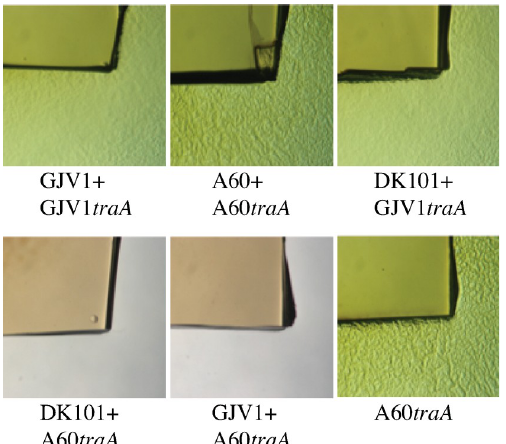
Fig 5. Inhibition of A60 traA swarming by DK101 and GJV1 is caused by TraA-independent killing. Mixes of kanamycin-resistant traA mutants with kanamycin-sensitive non-mutants were incubated on CTT agar without kanamycin and subsequently transferred on onto CTT agar with kanamycin. Lack of swarming out-growth on the kanamycin plates indicates killing of the focal traA mutant by the focal non-mutant prior to exposure to kanamycin. None of the traA mutants are killed by its parental strain and GJV1 traA is not killed by DK101 (top row). A60 traA is killed by both DK101 and GJV1 (bottom row).